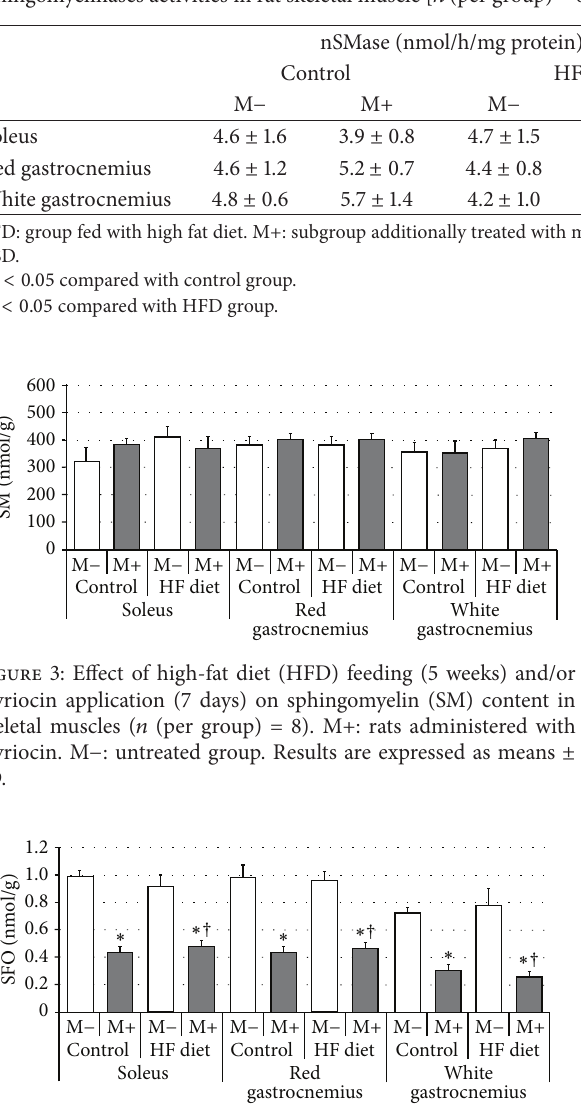
Figure 4: Effect of high-fat diet (HFD) feeding (5 weeks) and/or myriocin application (7 days) on sphingosine (SFO) content in skeletal muscles ( 𝑛 (per group) = 8). M+: rats administered with myriocin. M − : untreated group. Results are expressed as means ± SD. ∗ 𝑝 < 0.05 compared with control group. † 𝑝 < 0.05 compared with HF diet group.